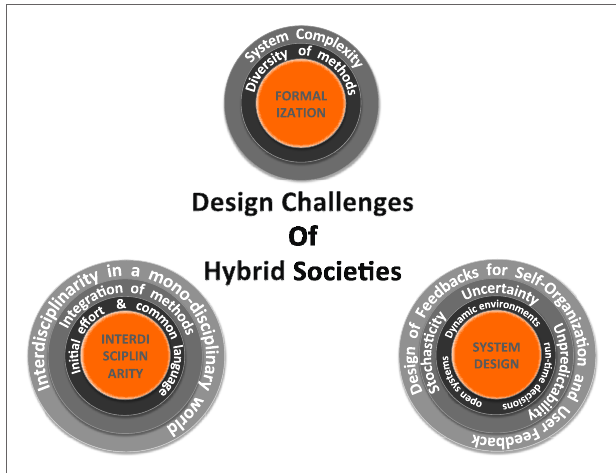
FiGUre 1 | Overview of design challenges in hybrid societies: primary challenge A – formalization, primary challenge B – system design, and primary challenge c – interdisciplinarity .